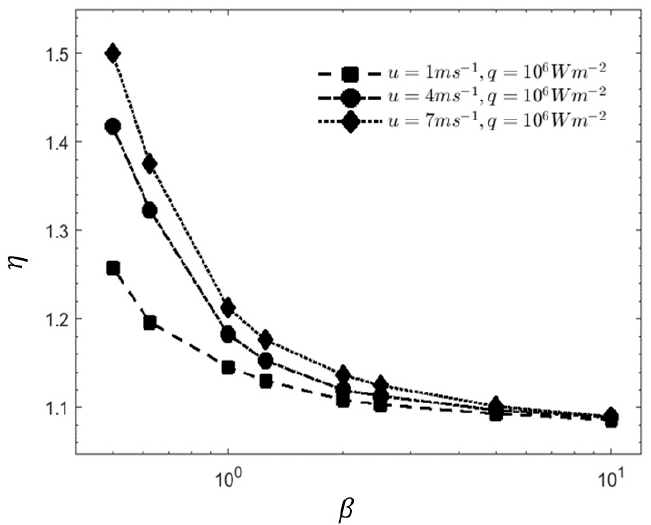
Figure 6. 𝜂 against 𝛽